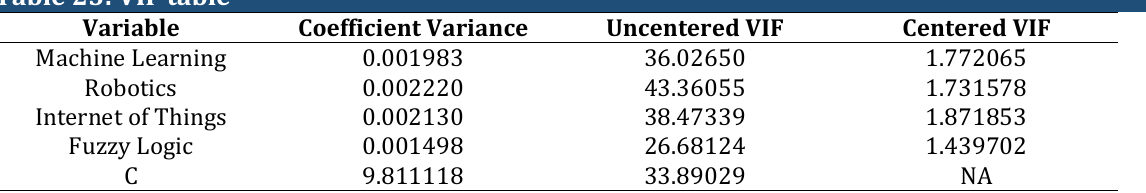
Table 23: VIF table Variable